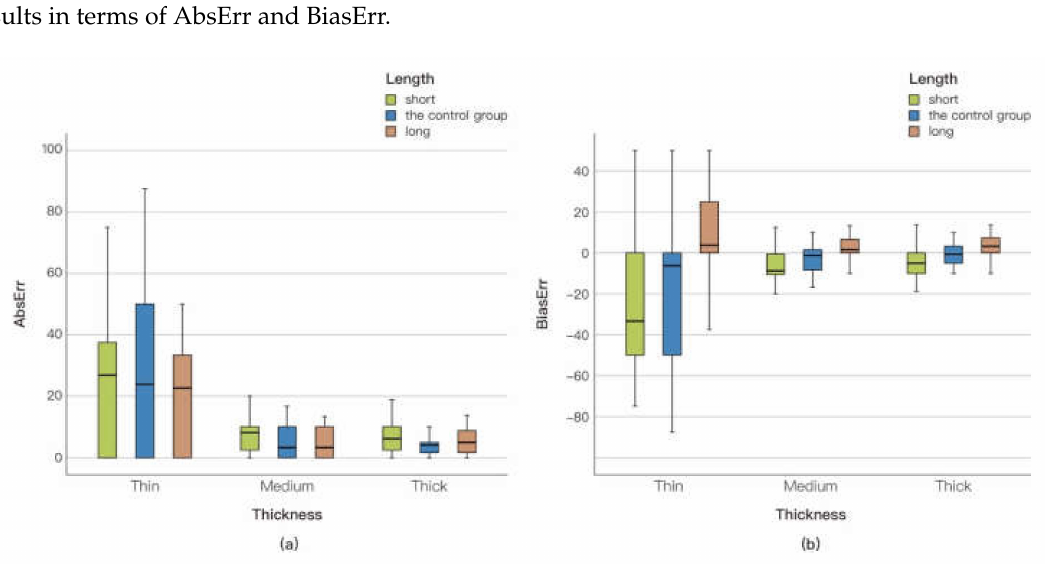
Figure 4. AbsErr ( a ) and BiasErr ( b ) of stimuli with di ff erent lengths and apparent thicknesses. AbsErr. We detected a significant interaction between length and apparent thickness for accuracy (F (4,801) = 5.840, p < 0.001, η 2 = 0.028). The results of the main e ff ects analysis show that length (F (1,801) = 14.644, p < 0.001, η 2 = 0.035) and apparent thickness (F = 14.644, p < 0.001, η 2 = 0.035) had a (1,801) significant e ff ect on